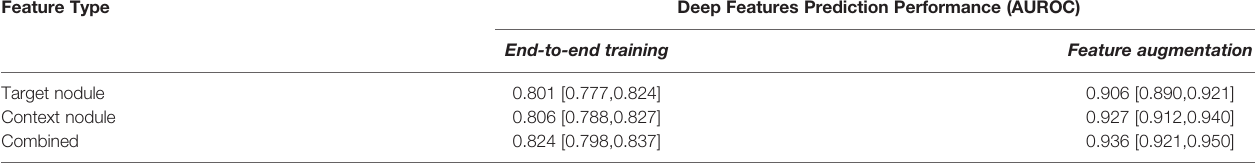
TABLE 4 | The prediction power of the deep learning-based analyses.